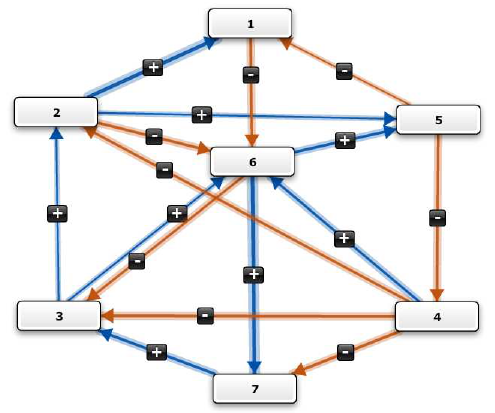
Figure 1. A general example of a system model (blue arrows labelled with (+) sign represent positive influence, red arrows labelled with ( − ) sign represent negative